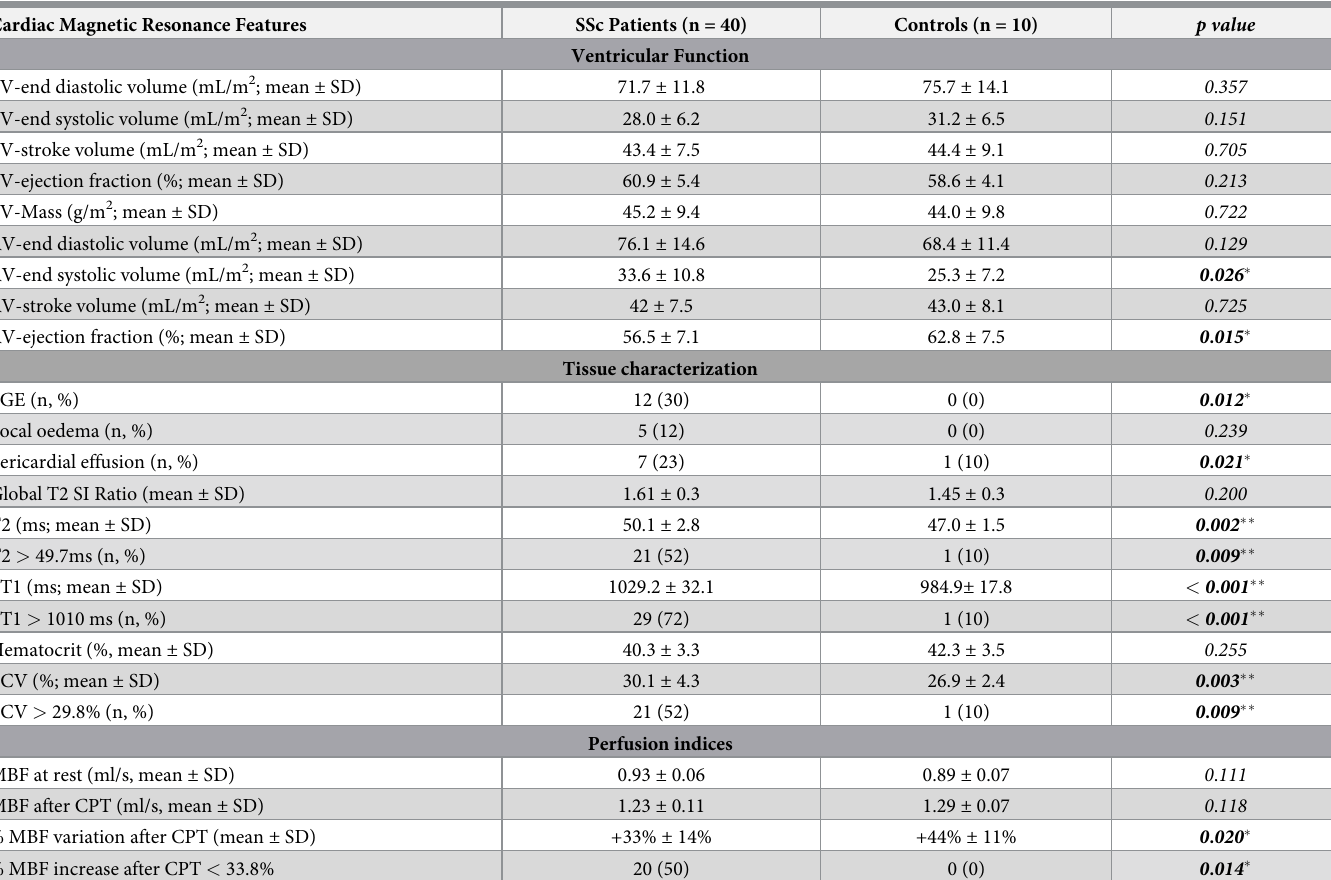
Table 2. SSc patient group: CMR